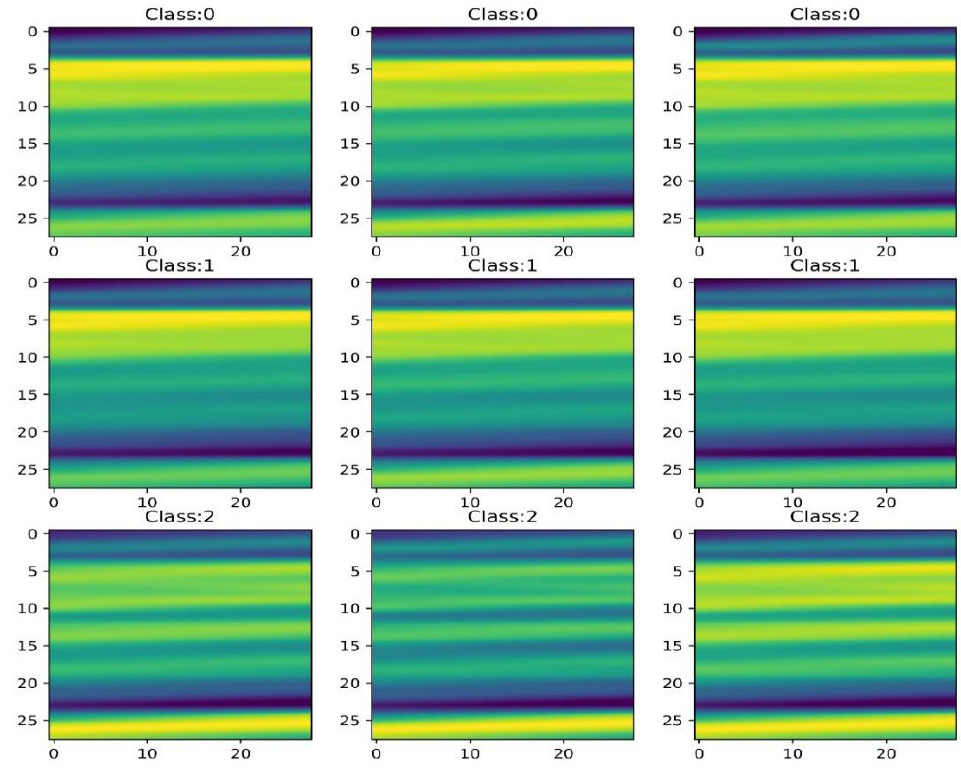
Figure 8. Nine pieces of 28 × 28 two-dimensional image information. Class 0, Class 1, and Class 2 were japonica rice varieties suitable for planting in the third, first, and second accumulation zones of Heilongjiang Province, respectively.